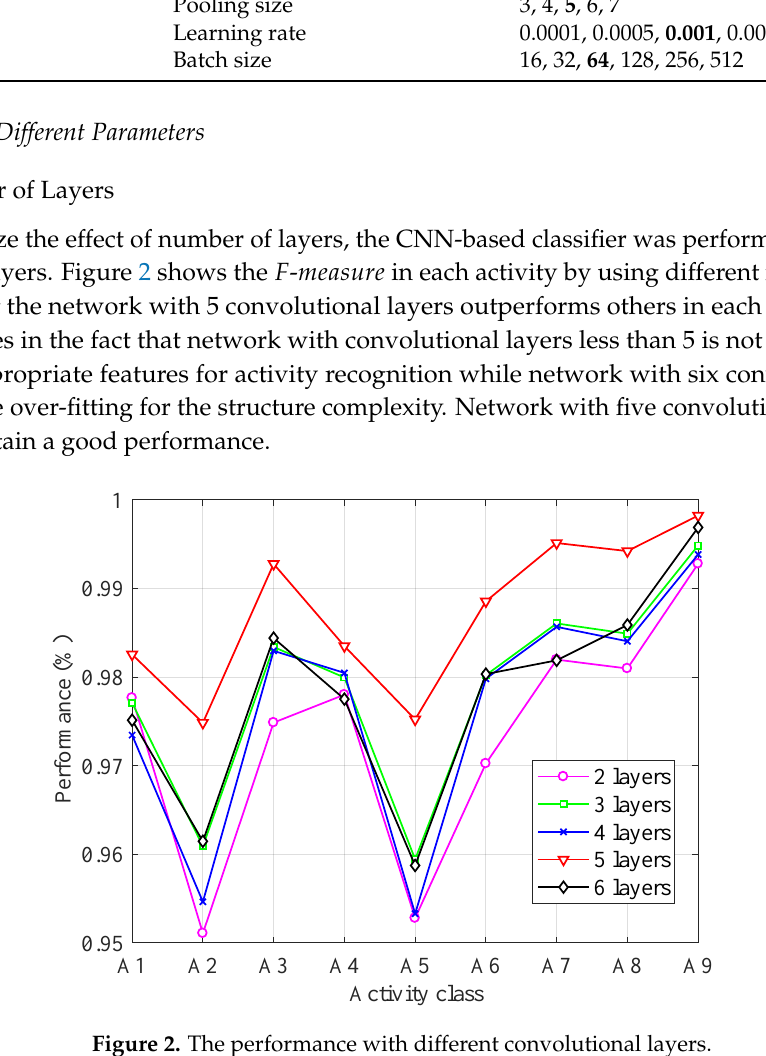
Figure 2. The performance with different convolutional